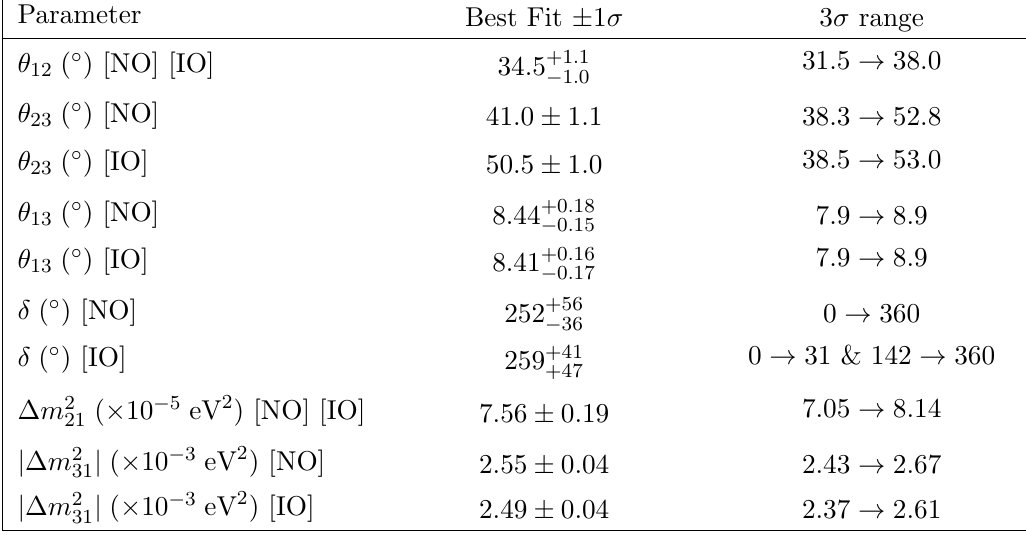
Table 1 . Neutrino oscillation parameters obtained from the global analysis of ref. [1] (see also refs. [2] and